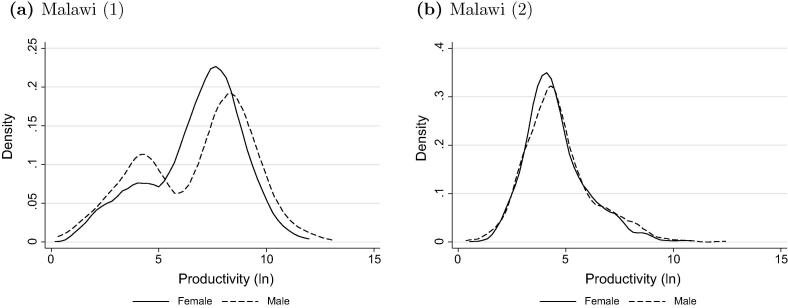
Productivity dispersal – by gender. Note(s): In (a) and (b) the continuous lines represent the productivity of enterprises with a female enterprise owner and the dotted lines the productivity of enterprises with a male enterprise owner. Malawi (1) shows the productivity measure using profit in the numerator, and Malawi (2) additionally makes use of time-use information of workers in the denominator.